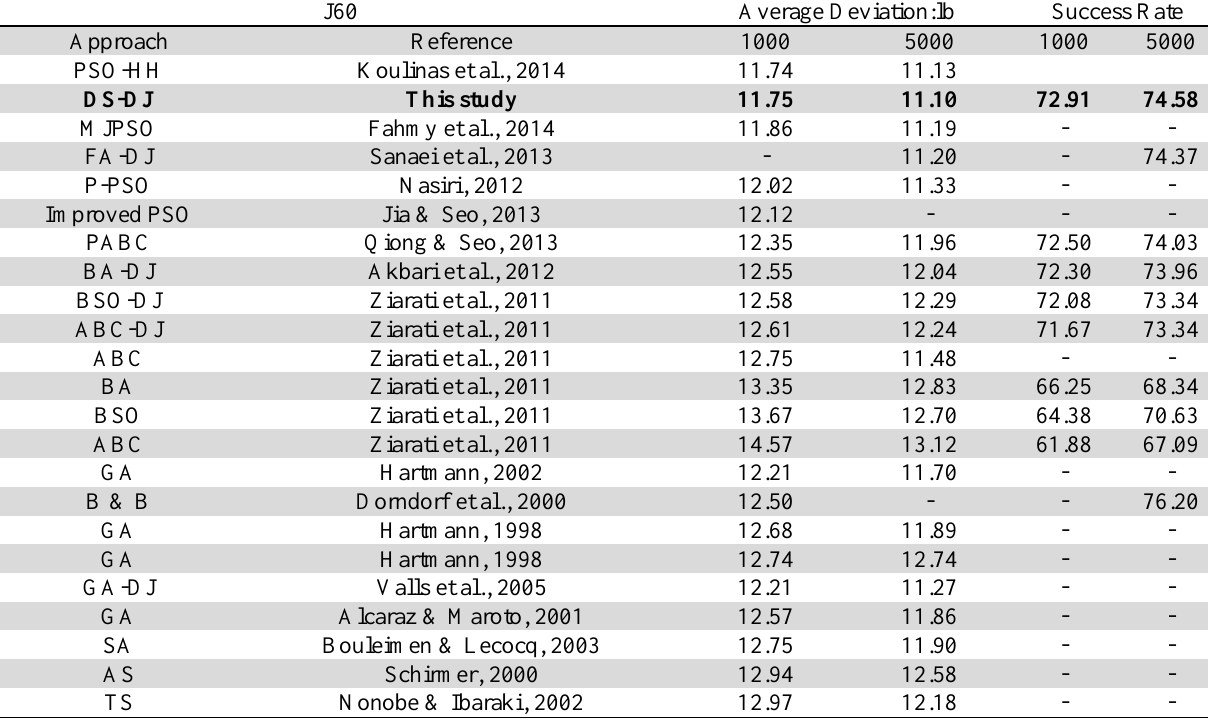
Table 5 Average deviation and success rates over J60